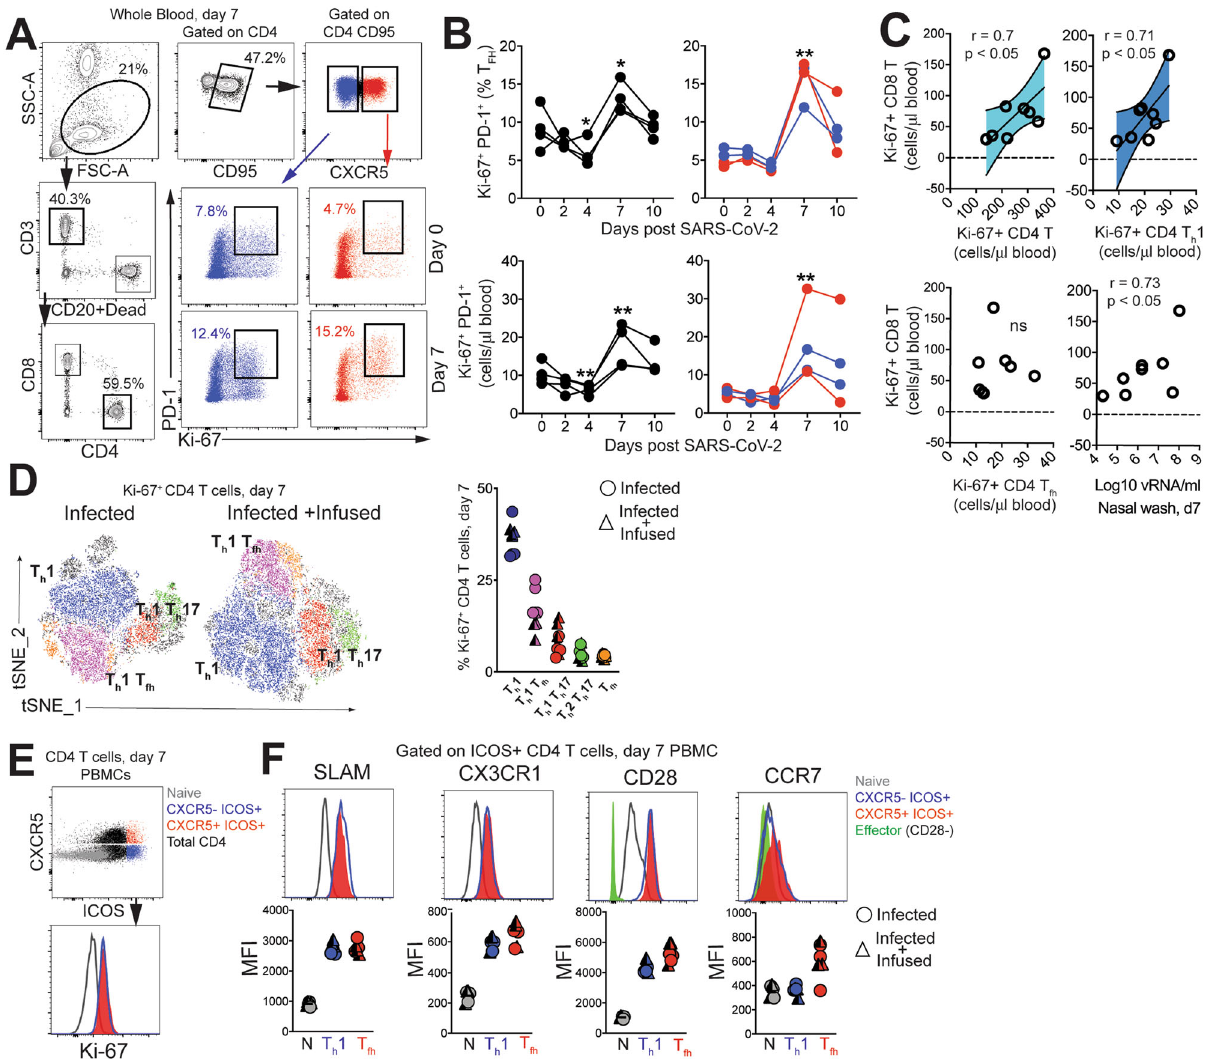
Fig. 3 SARS-CoV-2 infection increases the number CD4 T follicular helper cells in peripheral blood. A Representative gating strategy to capture CD4 T cells expressing Ki-67 and programmed death-1 (PD-1) in whole blood. Fluorochromes used were CD3-A700, CD20/Dead-APC-Cy7, CD8-BUV 805, CD4-BV650, CD95-BUV737, CXCR5-PE, PD-1-Pe Cy7, Ki-67-A488, CXCR3-BV786, CCR6-PECF594, CCR4-BV605, SLAM-A488, CX3CR1-PECF594, CD28-Pe-Cy7, CCR7-BV711, ICOS-BV786. B Kinetics show frequency and absolute counts of Ki-67 + PD-1 + CD4 T follicular helper cells (T fh ) cells (% of T fh cells; * p = 0.01 at d4 and d7 relative to d0 for infected and ** p = 0.002 at d7 relative to d0 for infused using a one-tailed paired t test, absolute T fh cell counts; ** p = 0.003 at d4 and ** p = 0.0086 at d7 relative to d0 for infected and ** p = 0.003 at d7 relative to d0 for infused using a one-tailed paired t test. Data are from a real-time longitudinal staining of whole blood performed a single time) C correlation plots of Ki-67 + CD8 T cells against Ki-67 + CD4 subsets, and viral(v)RNA (all day 7) (two-tailed Pearson test p values shown. 95% con fi dence bands of the best fi t line are shown) D t-distributed stochastic neighbor embedding (tSNE) plot based on fl ow cytometry data of CD4 Ki-67 + events at Day 7 from infected (16,197 events) and infected + infused animals (22,406 events); dot plot shows frequency of Ki-67 + CD4 T-cell subsets. ( E – F ) Histograms and median fl uorescence intensity (MFI) dot plots illustrate relative expression of signaling lymphocyte activation molecule (SLAM), CX3C chemokine receptor 1 (CX3CR1), CD28, and C-C chemokine receptor type 7(CCR7) within four different populations identi fi ed at Day 7 in peripheral blood mononuclear cells (PBMCs, n = 7). Unique symbols identify animals in each of the experimental